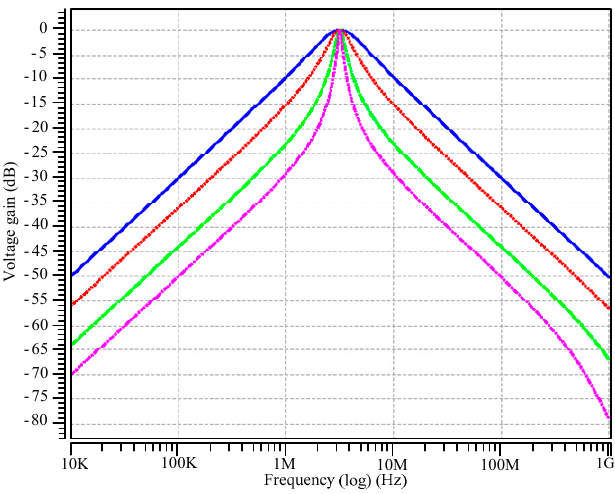
Figure 9. The TIM-simulated frequency responses of Figure 2 ( a ) lowpass filter; ( b ) bandpass filter; ( c ) highpass filter; and ( d ) bandpass filter.